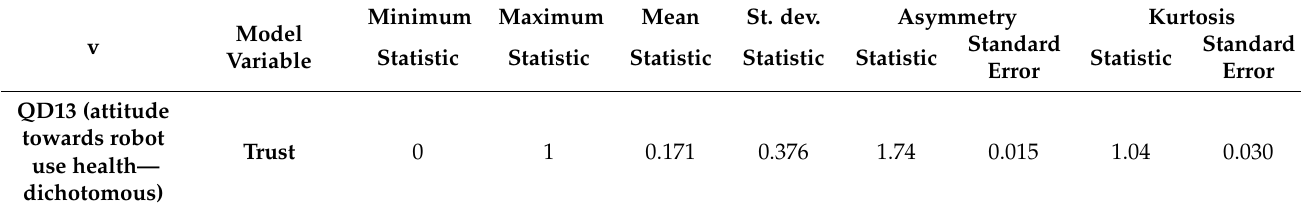
Table A1. The model’s descriptive